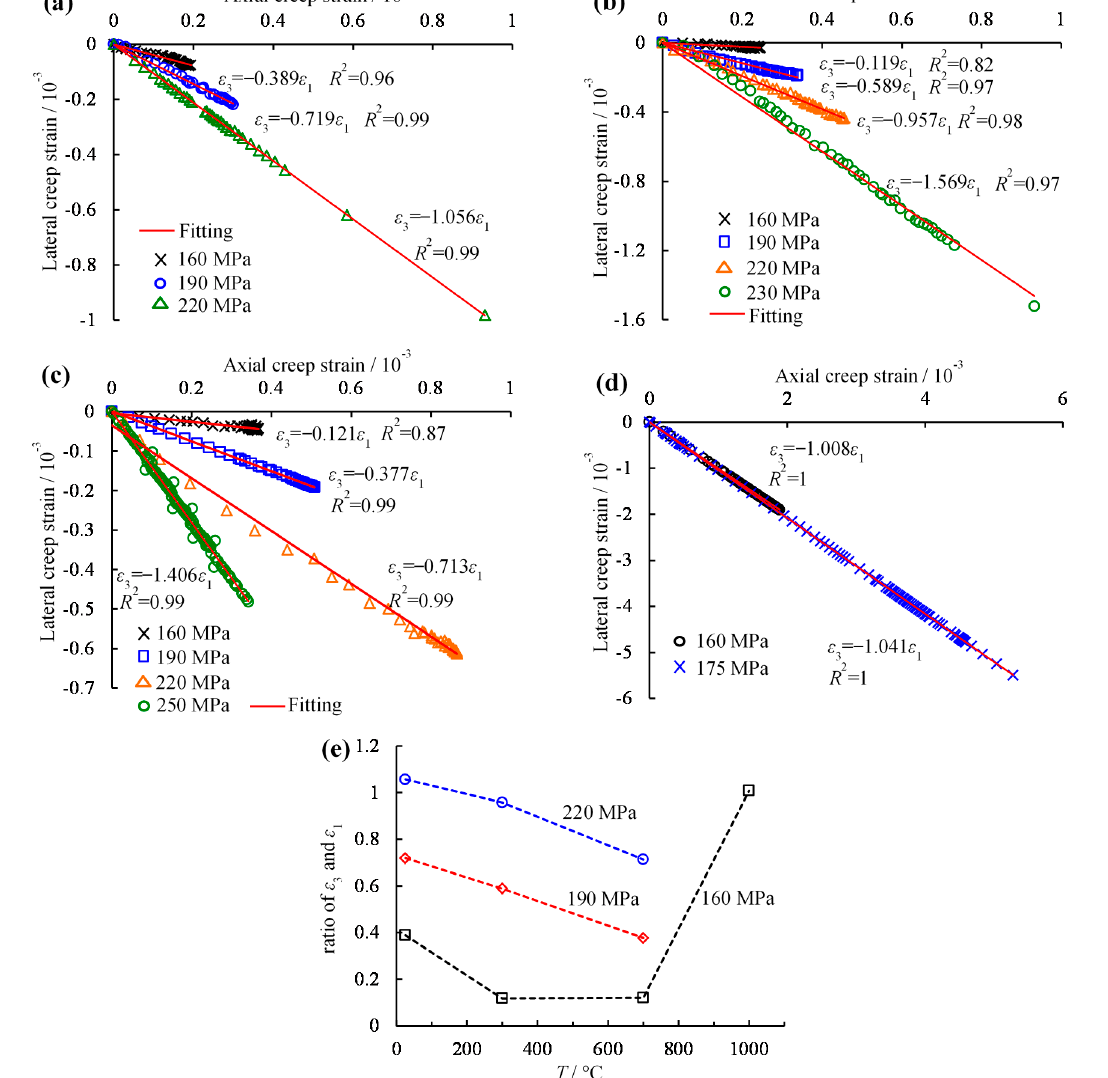
Figure 14. Relationships between the axial creep strain and the lateral creep strain at different temperatures: ( a ) 25 °C; ( b ) 300 °C; ( c ) 700 °C; ( d ) 1000 °C; ( e ) Relation between the slope of fitting line and temperature.